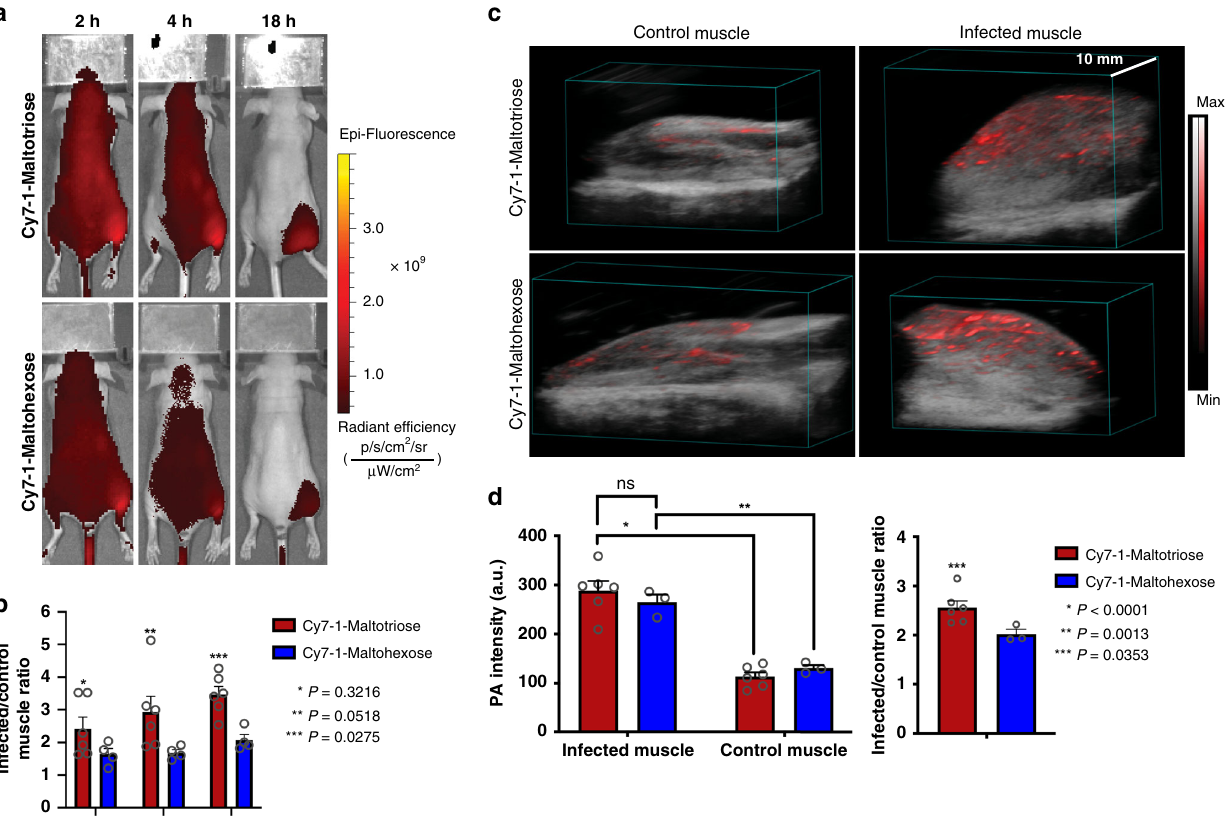
Fig. 4 In vivo comparison between Cy7-1-maltotriose and Cy7-1-maltohexose in an E. coli -induced myositis murine model. a In vivo fl uorescence images at 2, 4, and 18 h post-injection of either Cy7-1-maltotriose (top) or Cy7-1-maltohexose (bottom) showing accumulation of both probes in the right thigh muscle ( E. coli ). Qualitatively higher fl uorescence signal in the infected muscle (right thigh) when injecting Cy7-1-maltotriose (top) compared to Cy7-1- maltohexose (bottom) is observed. b Bar plot representation of ratio of fl uorescence in the infected thigh vs control thigh. Higher fl uorescence signal in the infected muscle (right thigh) when injecting Cy7-1-maltotriose ( n = 6) was observed compared to injecting Cy7-1-maltohexose ( n = 4) and this was signi fi cant at 18 h post-injection ( P < 0.0275). c 3D rendered photoacoustic image overlaid on ultrasound image of a mouse 21 h post-injection of Cy7-1- maltotriose (top) and Cy7-1-maltohexose (bottom). Images show infected (right thigh) and control (left thigh) muscle. Evident PA signal is observed in the infected thigh muscle when injecting either compounds while minimal signal is observed in the control thigh muscle. d Bar plot representation of the quanti fi ed photoacoustic signal intensity in the photoacoustic images acquired 21 h after injection of Cy7-1-maltotriose and Cy7-1-maltohexose. The quanti fi ed signal shows signi fi cantly higher PA signal in the infected muscle compared to control muscle when injecting either compounds (left). No signi fi cant difference in PA signal was observed between the two compounds. Signi fi cantly higher infected over the control PA signal ratio was observed when injecting Cy7-1-maltotriose ( n = 6) compared to Cy7-1-maltohexose ( n = 3) ( P < 0.0353) (right). Bar graphs show mean and S.E.M. Statistical analysis was performed using two-way ANOVA. ns no statistically signi fi cant difference ( P > 0.05). The source data underlying Fig. 4b and d are provided in a Source Data fi